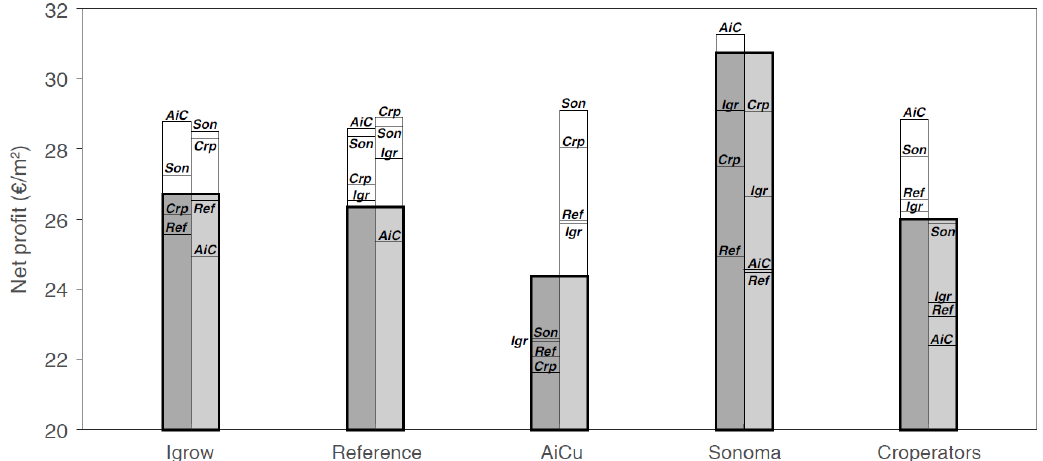
Figure 14. Realized net profit (greyscale bars) and predicted net profit per greenhouse compartment of different teams (iGrow, Reference, AiCU, Sonoma, The Croperators) using the cropping (1st bar), or lighting (2nd bar) strategy of each of the other teams. The predicted net profit under the different CO 2 strategies for each team is not illustrated due to the limited effect on net profit.